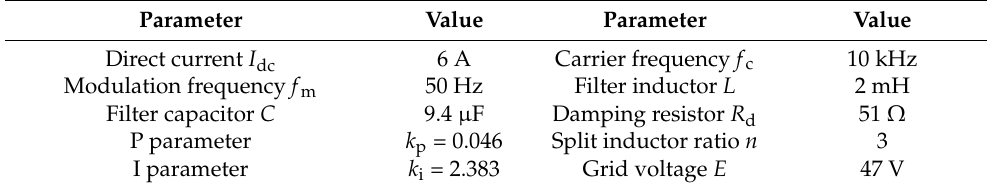
Table 2. Experimental